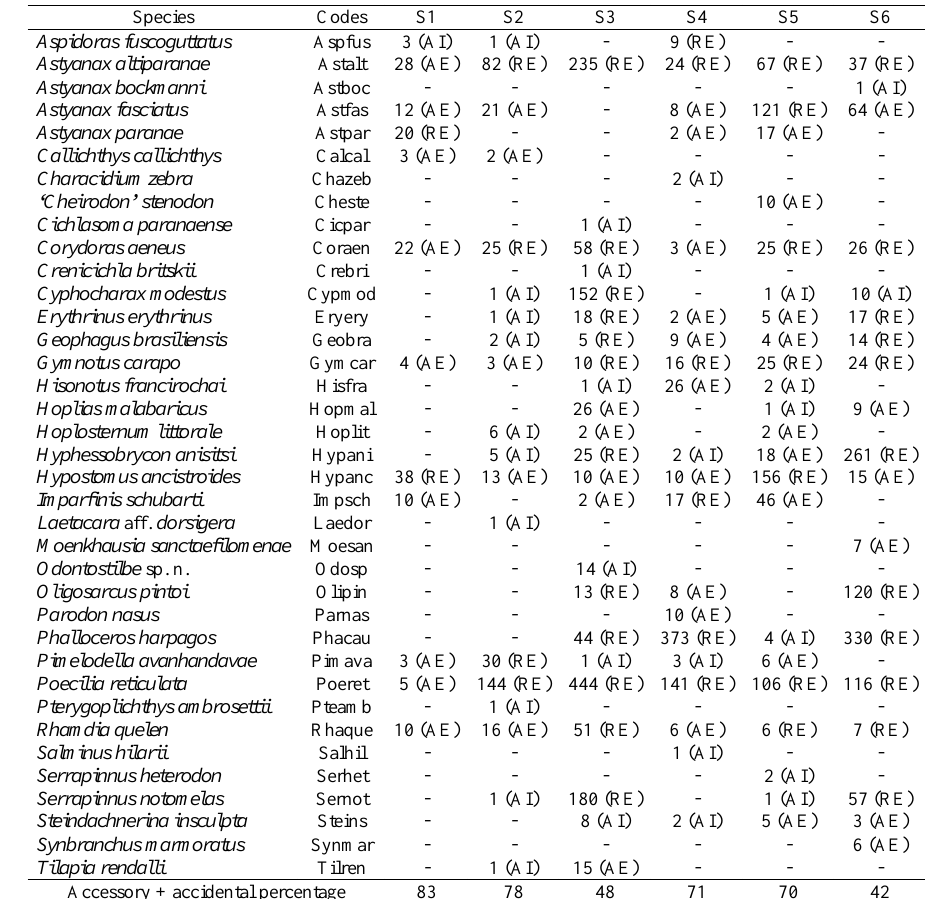
Table 3. Species, species codes, abundance and their occurrence (RE, resident; AE, accessory; AI, accidental) in the six stream stretches (S1-S6) studied in the upper rio Turvo